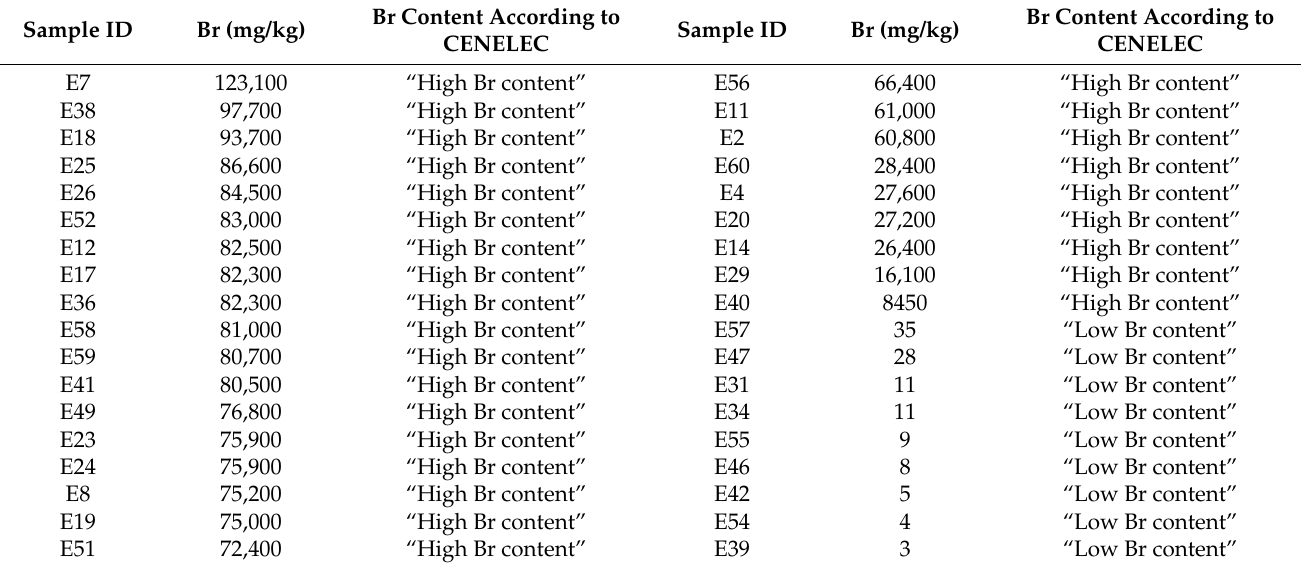
Table 3. Br (mg/kg) content of each collected sample as determined by XRF analysis and Br content class according to the CENELEC technical specification “High Br content” (Br content > 2000 mg/kg) and “Low Br content” (Br con- tent < 2000